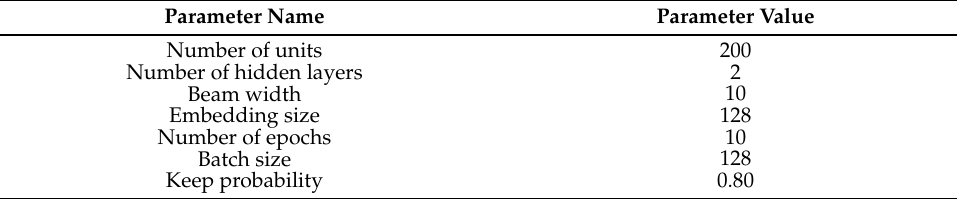
Table 3. Experiment parameters for the learning rate sensitivity analysis.